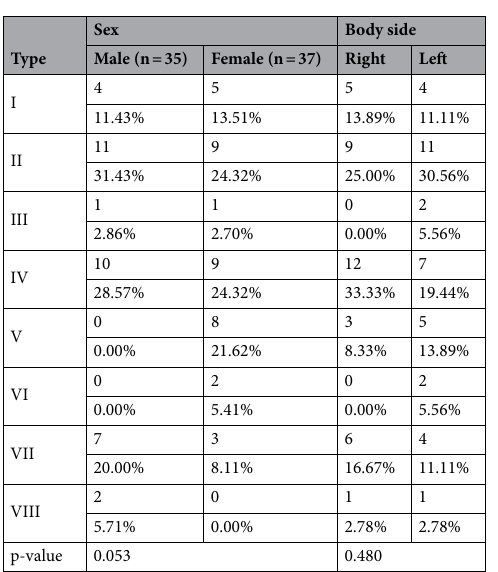
Table 1. Occurrence of all eight identified types with relation to sex and body